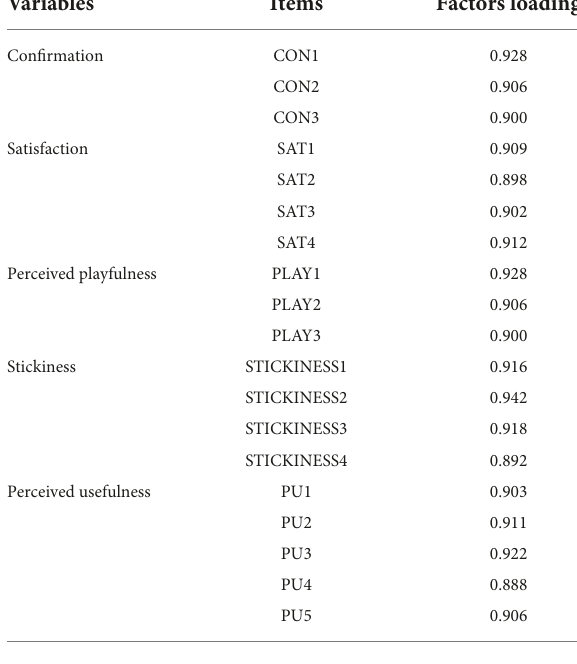
TABLE 3 Cronbach’s α , composite reliability and